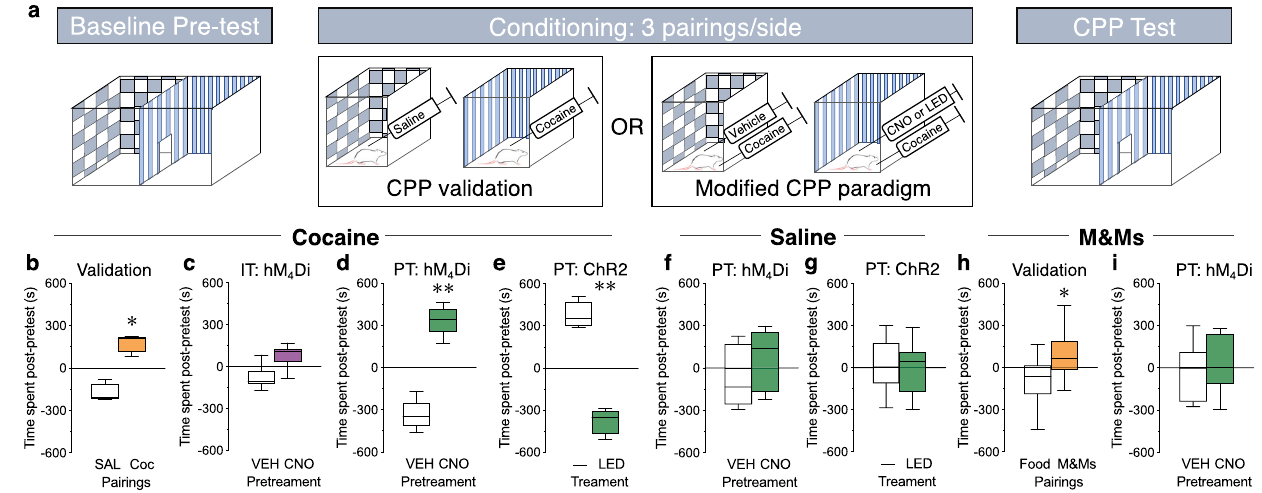
Fig. 3 PT inhibition enhances the rewarding properties of cocaine. a Baseline: Rats freely explore chamber for 20 min. Conditioning: Rats receive three pairings/side of saline and 10 mg/kg cocaine, i.p. (for conditioned place preference (CPP) validation) or vehicle (VEH) + cocaine and CNO (5 mg/kg, i.p.) (or LED light; 20 Hz, 20 ms pulses) + cocaine (modi fi ed CPP paradigm) over 3 days (2 conditioning sessions/day). CPP test: 24 h post-conditioning, rats freely explore chamber for 20 min. b – i Bar and whisker plots where bars represent the mean ± SEM difference in time spent on a side between the post- conditioning CPP test and the Baseline pretest. b Validation: Rats spent signi fi cantly more time on the cocaine-paired side (orange) than the saline-paired side, indicating a CPP to cocaine. N = 4. c IT hM 4 Di: There was no difference in the time spent on the CNO + cocaine-paired side (purple) compared to the VEH + cocaine-paired side, indicating that IT inhibition does not modulate cocaine reward. N = 6. d PT hM 4 Di: Rats spent signi fi cantly more time on the CNO + cocaine-paired side (green) than the VEH + cocaine-paired side, indicating that PT inhibition enhances cocaine reward. N = 6. e PT ChR2: Rats spent signi fi cantly less time on the light + cocaine-paired side (green) compared to cocaine alone, indicating that PT stimulation decreases cocaine reward. N = 4. f There was no difference in the time spent when rats received VEH or CNO (green) prior to saline on each side, indicating that PT inhibition alone is not reinforcing. N = 5. g There was no difference in the time spent when rats received light + saline (green) compared to saline alone, indicating that PT stimulation alone is not aversive. N = 4. h Validation: Rats spent signi fi cantly more time on the M&M candy-paired side (orange) compared to the food- paired side, indicating a CPP to a hedonic natural reward. N = 9. i PT hM 4 Di: There was no difference in the time spent on the CNO + M&M-paired side (green) compared to the VEH + M&M-paired side, indicating that PT inhibition does not modulate the rewarding properties of a natural reinforcer. N = 6, * p < 0.05, ** p < 0.01, paired t